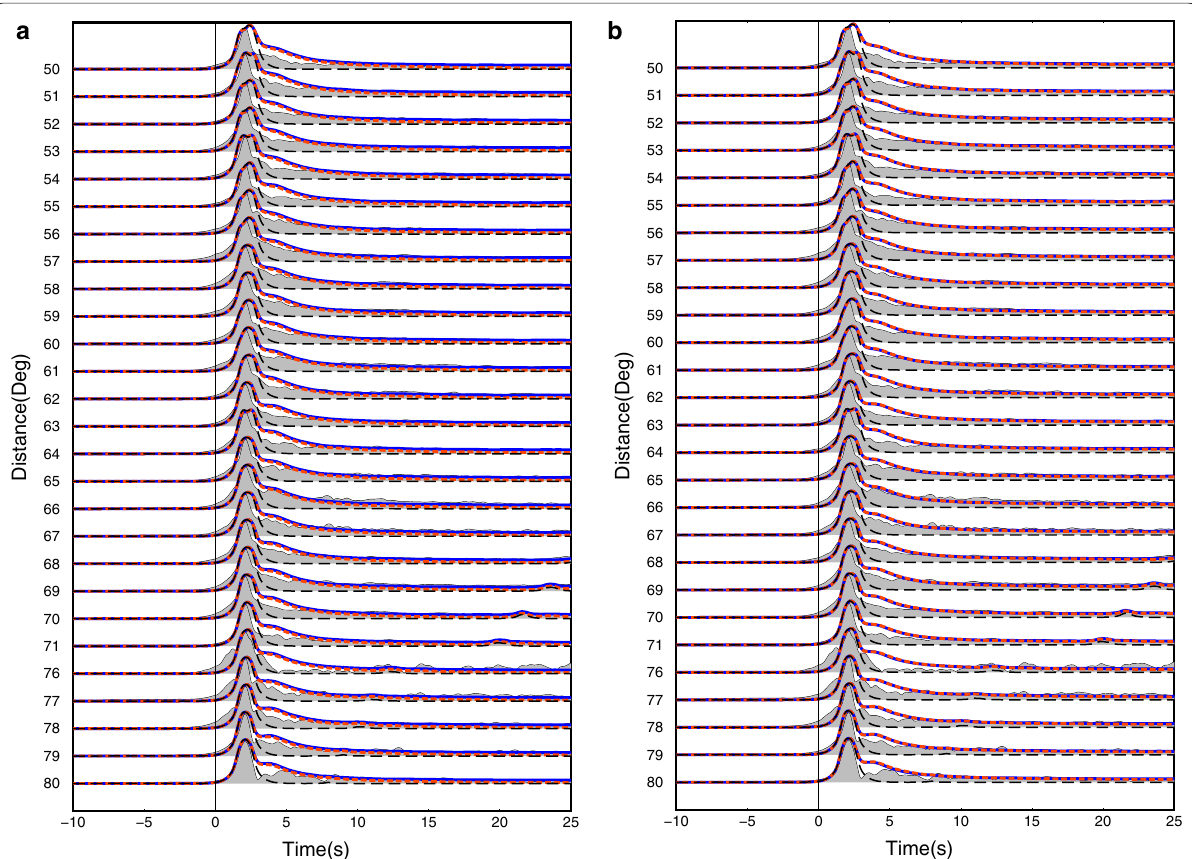
Fig. 11 A demonstration of how the parameters, attenuation ( Q ) and velocity-density variation scaling ratio ( v ), affect the P-wave coda synthetics. The scattering model is an exponential random medium with thickness of 130 km, correlation length of 0.8 km and RMS velocity perturbation of 5%. a Synthetics for models with Q 100 (dashed red lines) and Q 800 (blue lines) in the mantle, respectively. b Synthetics for models with v = = (dashed red lines) and v 0.8 (blue lines), =